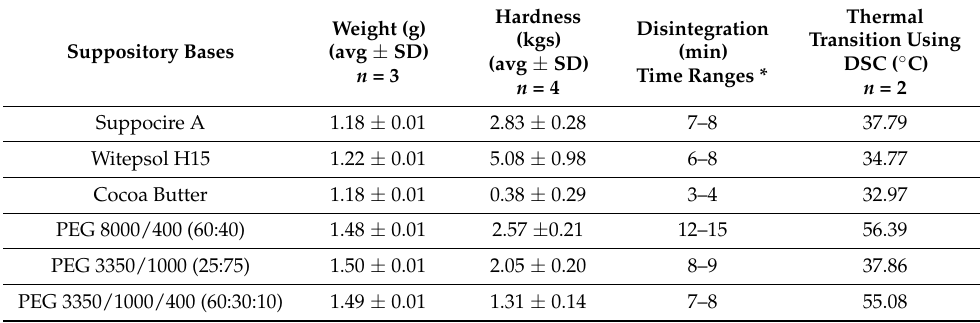
Table 1. Characterization of placebo